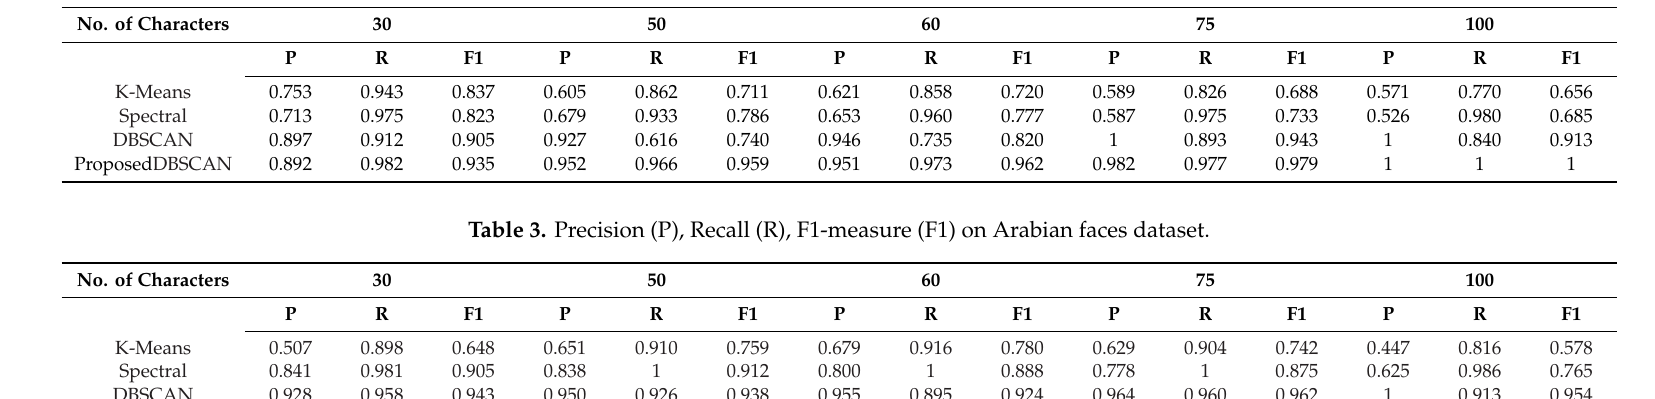
Table 2. Precision (P), Recall (R), F1-measure (F1) on LFW dataset.